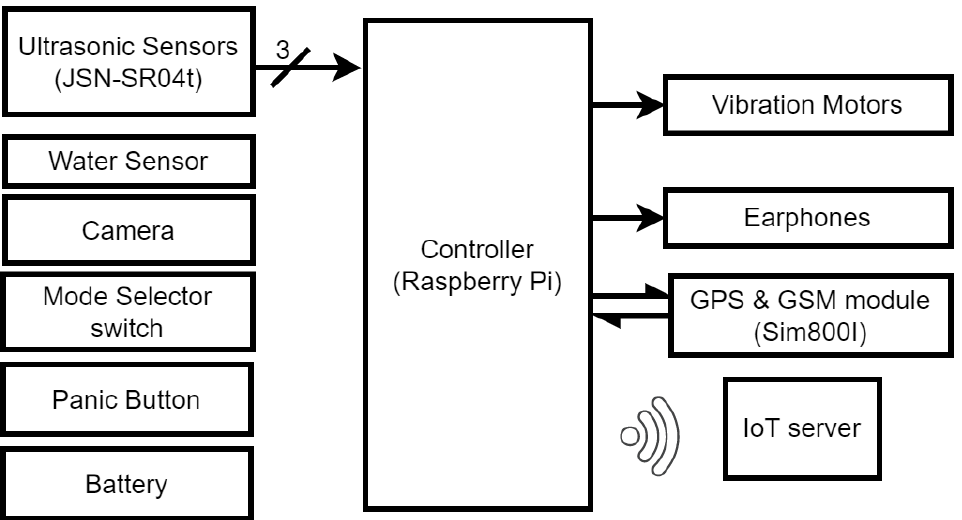
Figure 2. Block diagram of electronic circuitry for the smart